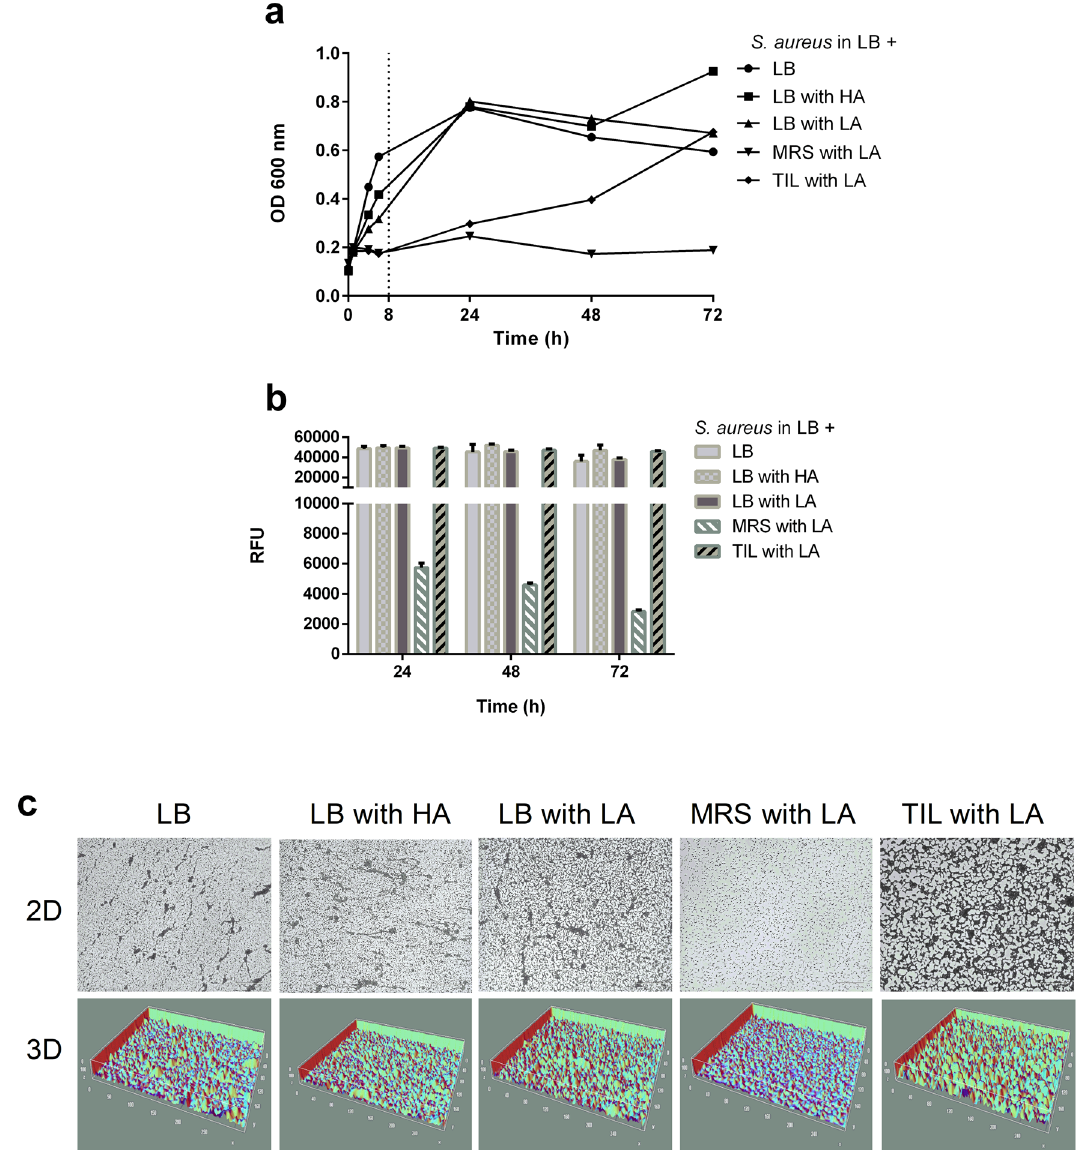
Figure 2. Comparison of S. aureus growth and biofilm formation in standard and acidic media . ( a ) Pathogen growth curves in standard LB and acidic media (pH = 4.3). Data are expressed as mean ± SD. All the experiments (n = 4) were repeated 3 times on different days. OD = optical density. HA = hydrochloric acid. LA = lactic acid. ( b ) Biofilm viability assay in standard and acidic media after 24, 48, and 72 h incubation. Data are expressed as mean ± SD of 3 independent experiments (n = 4). RFU = relative fluorescence units. ( c ) Representative 2D and 3D images of crystal violet (CV) stained S. aureus biofilm at 72 h grown in LB and acidic media. 2D pictures magnification: 460X. Scale bar: 100